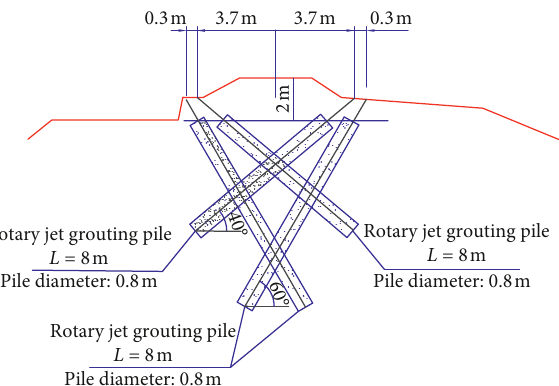
Figure 5: Plane layout of existing railway subgrade strengthened by inclined rotary jet grouting pile.